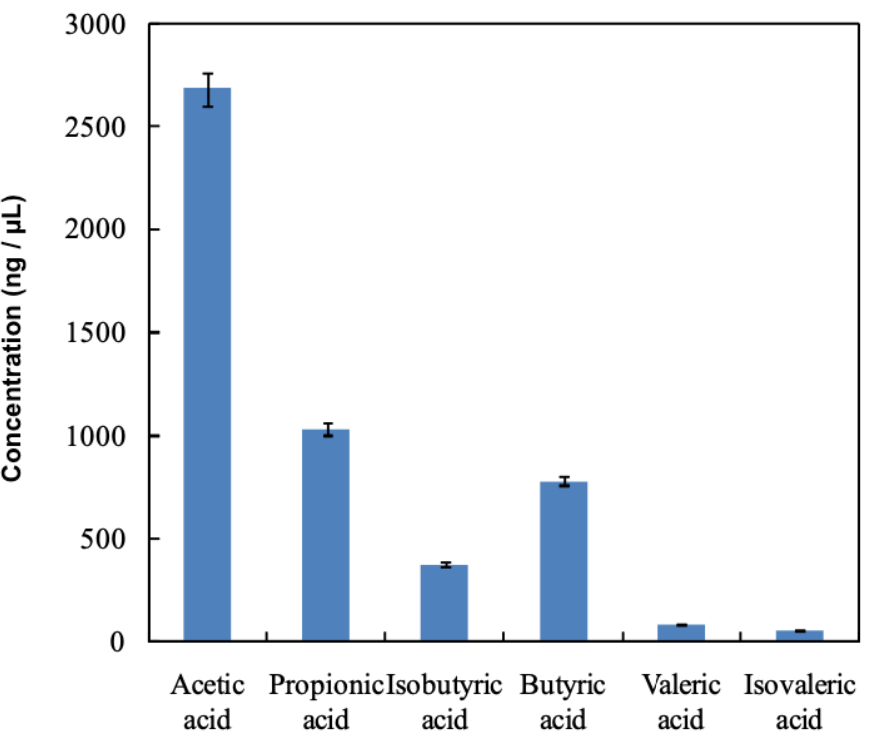
Figure 2. Volatile fatty acid concentration in rumen fluid using the catalytic esterification reaction method.